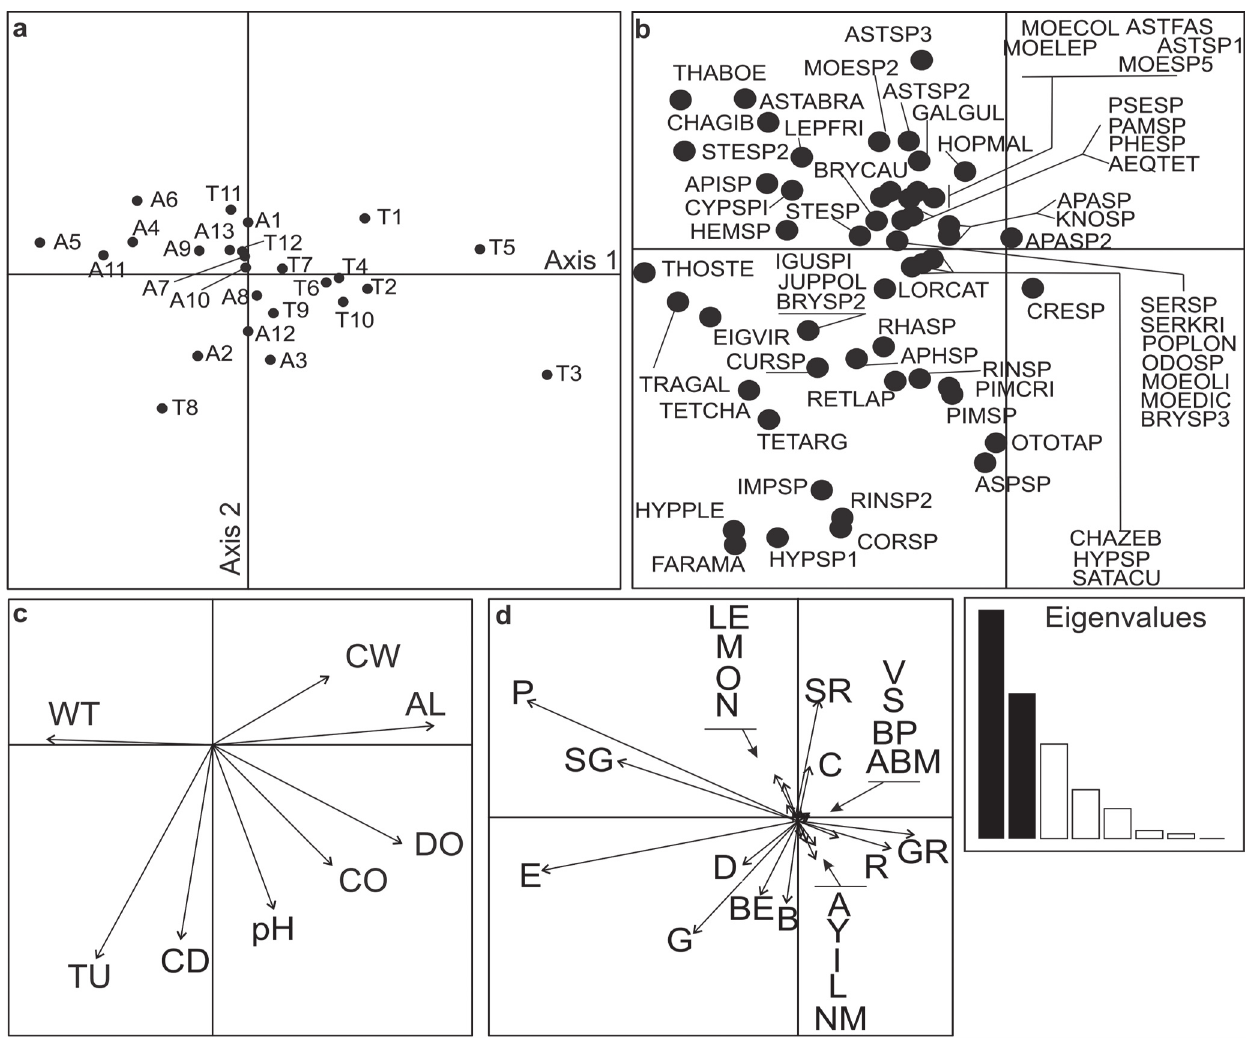
Fig. 2. Ordination of sampling stations (a), species (b), environmental variables (c) and functional traits (d) resulting of the RLQ analysis. In (a) the letter preceding numbers indicates the river basin (A=Araguaia; T=Tocantins). In (c) AL=altitude; CO=conductivity; CD=channel depth; CW=channel width; DO=dissolved oxygen; TU=turbidity; WT=water temperature. Consult Tables 1 and 2 for codes used in (d) and (b), respectively. The eigenvalues of the axes are displayed in the smallest box with the first two axes featured in